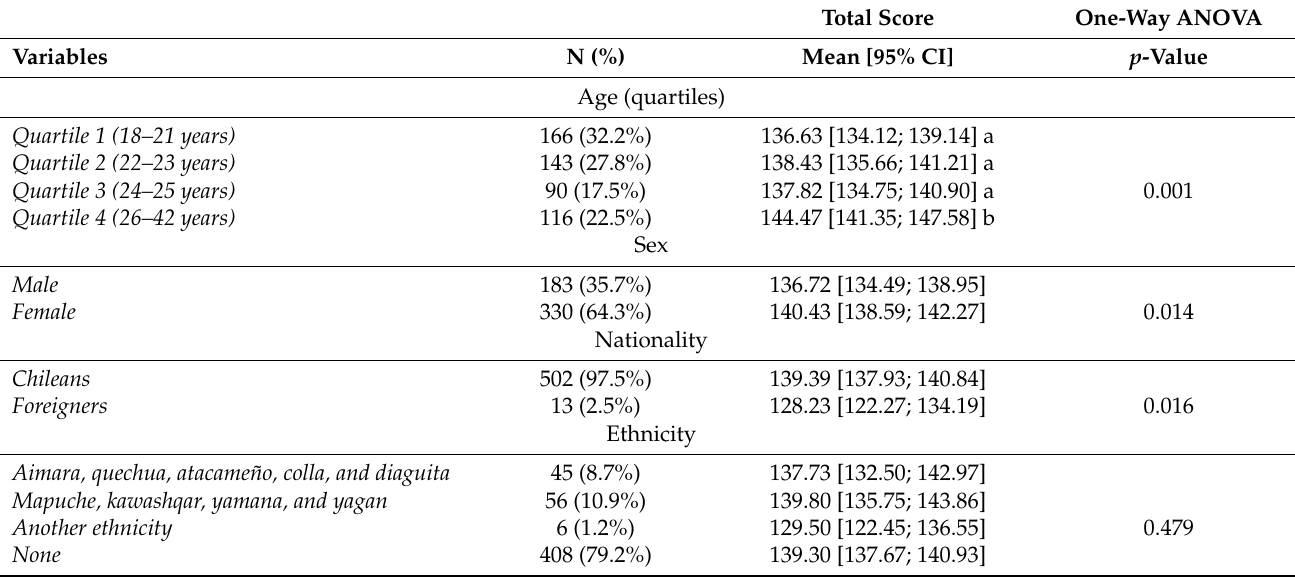
Table 2. Sociodemographic